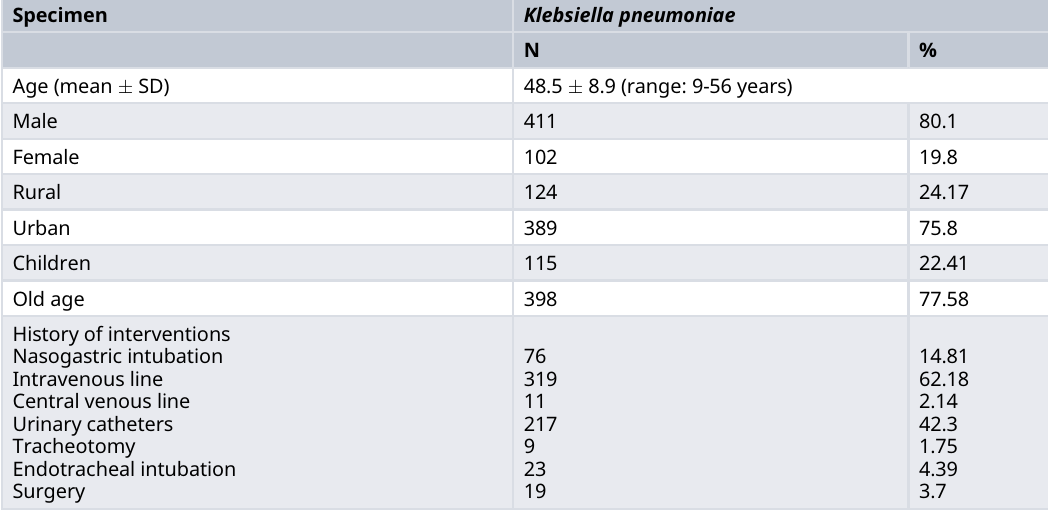
Table 2. Demographic characteristics and interventions in study population (n = 513).